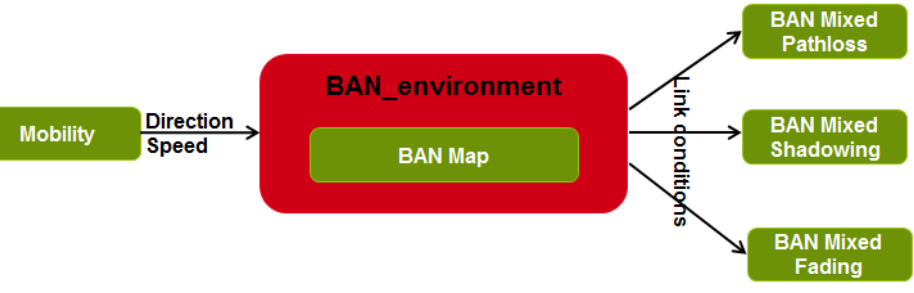
Figure 3. Central position of the BAN environment between the mobility and propagation